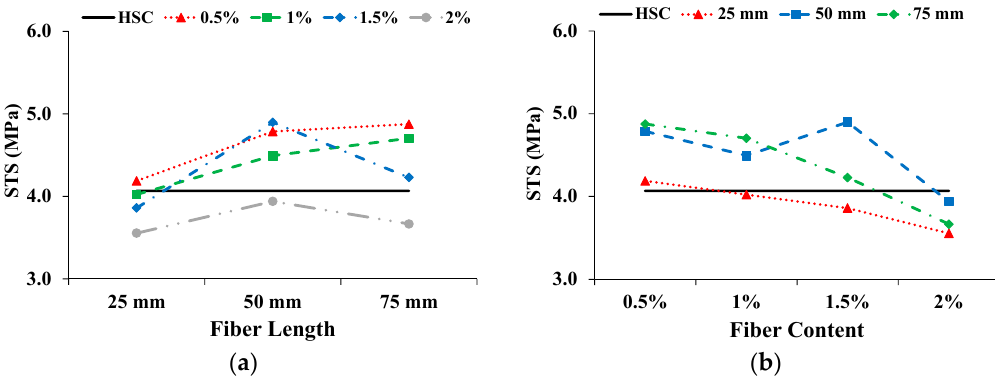
Figure 9. Influence on STS: ( a ) Fiber length; ( b ) Fiber content .